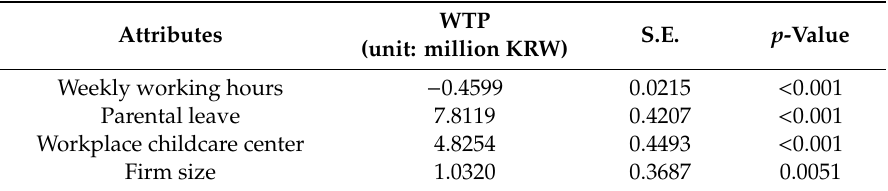
Table 6. WTP for workplace attributes.